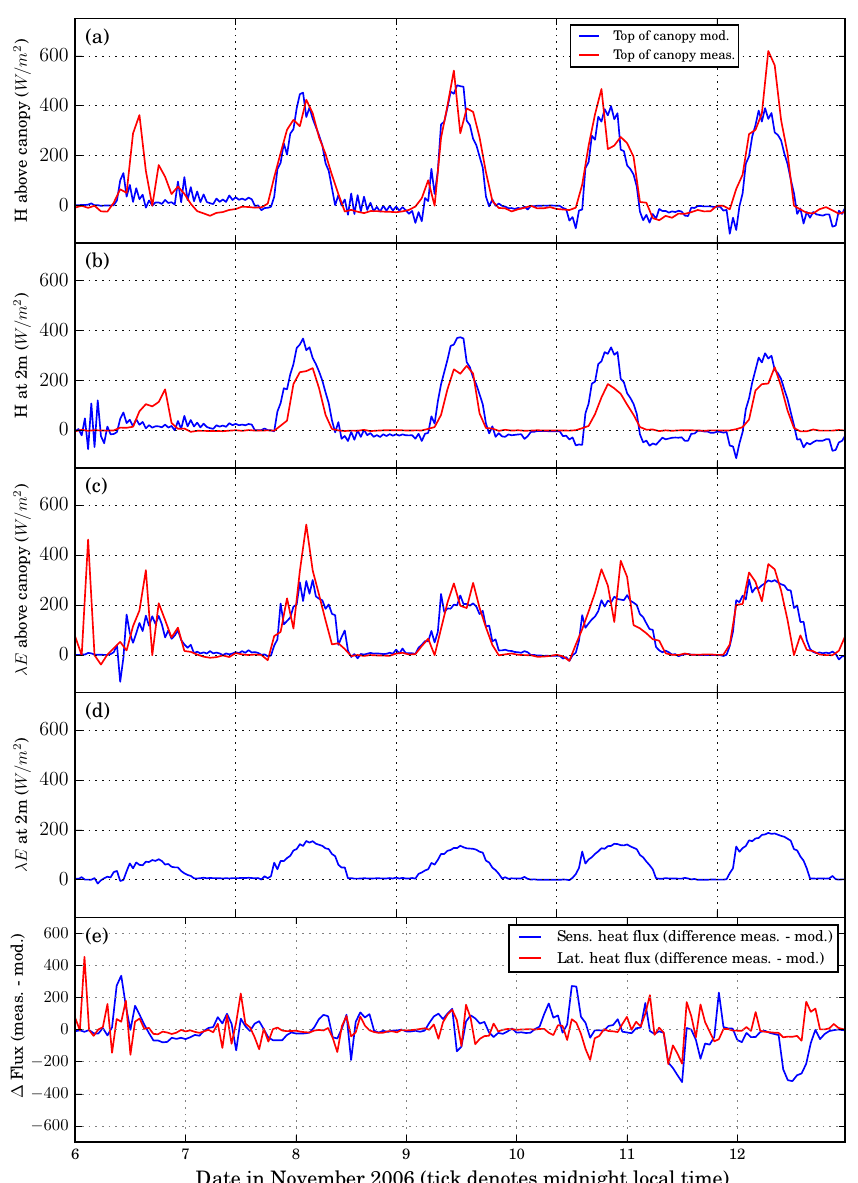
Figure 6. Short-term simulated and observed energy fluxes: (a) sensible heat fluxes at a height of 50m; (b) as (a) for latent heat flux; (c) measured and modelled sensible heat flux at 2m above the ground; (d) modelled latent heat flux at 2m above the ground (measurements not available); (e) difference in measured and modelled sensible and latent heat flux at a height of